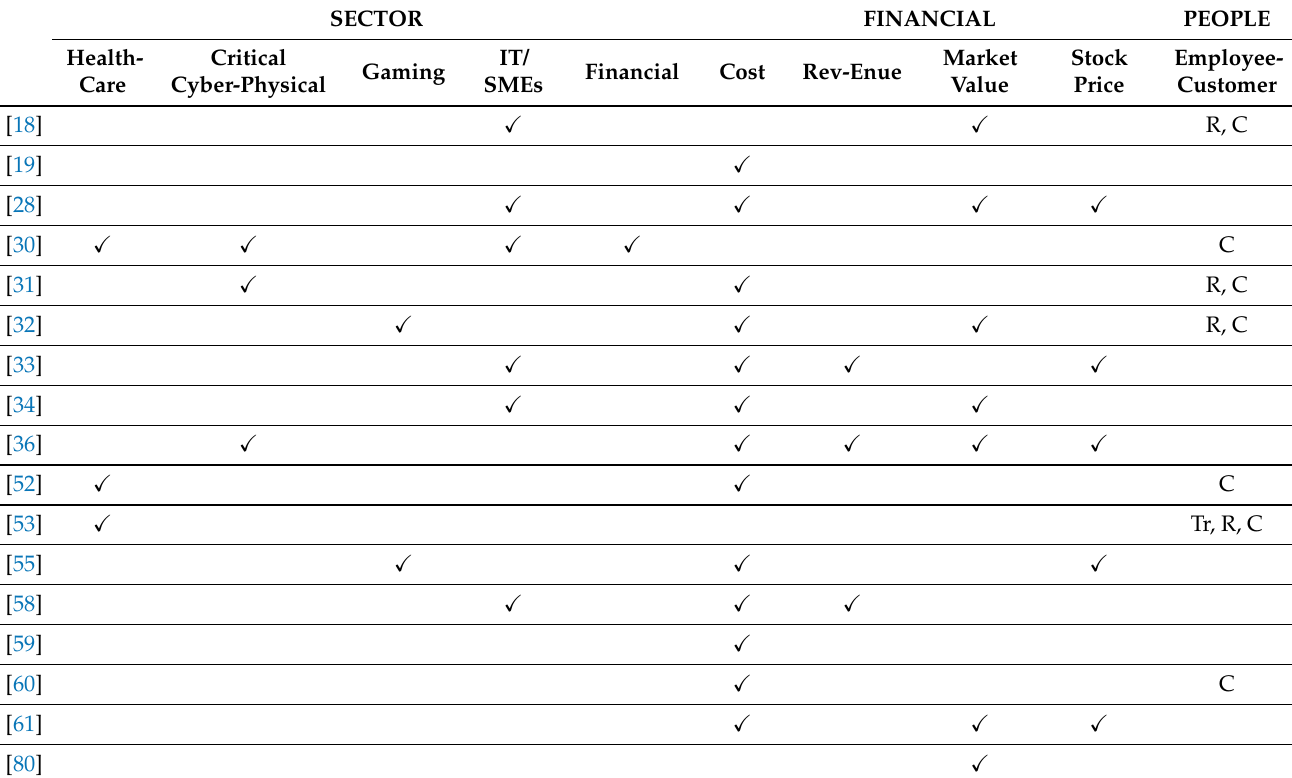
Table 4. Contribution of various studies on the impact of data breaches. The impact on the People category can result in the loss of Trust, Reputation, Turnover and Confidence, which are represented by Tr , R , Tu , and C ,